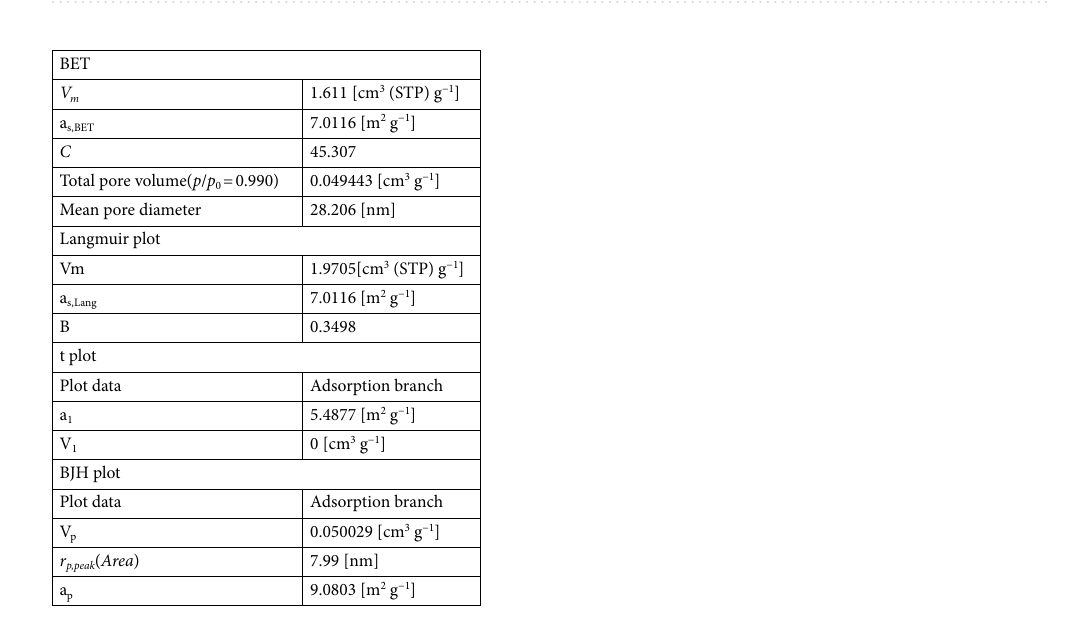
Figure 9. N 2 adsorption (blue line)—desorption (red line) isotherm and corresponding diagrams pore size distributions (BJH, BET, Langmuir, t -plot).